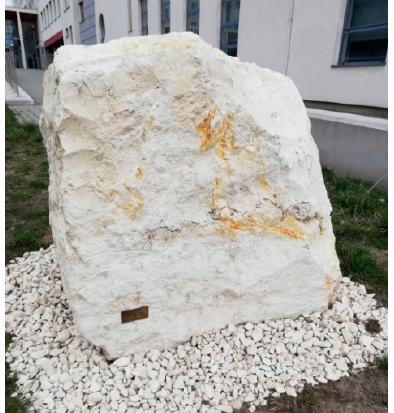
Figure 8. Upper Jurassic limestone block from the Morawica Mine (boulder No. 2).